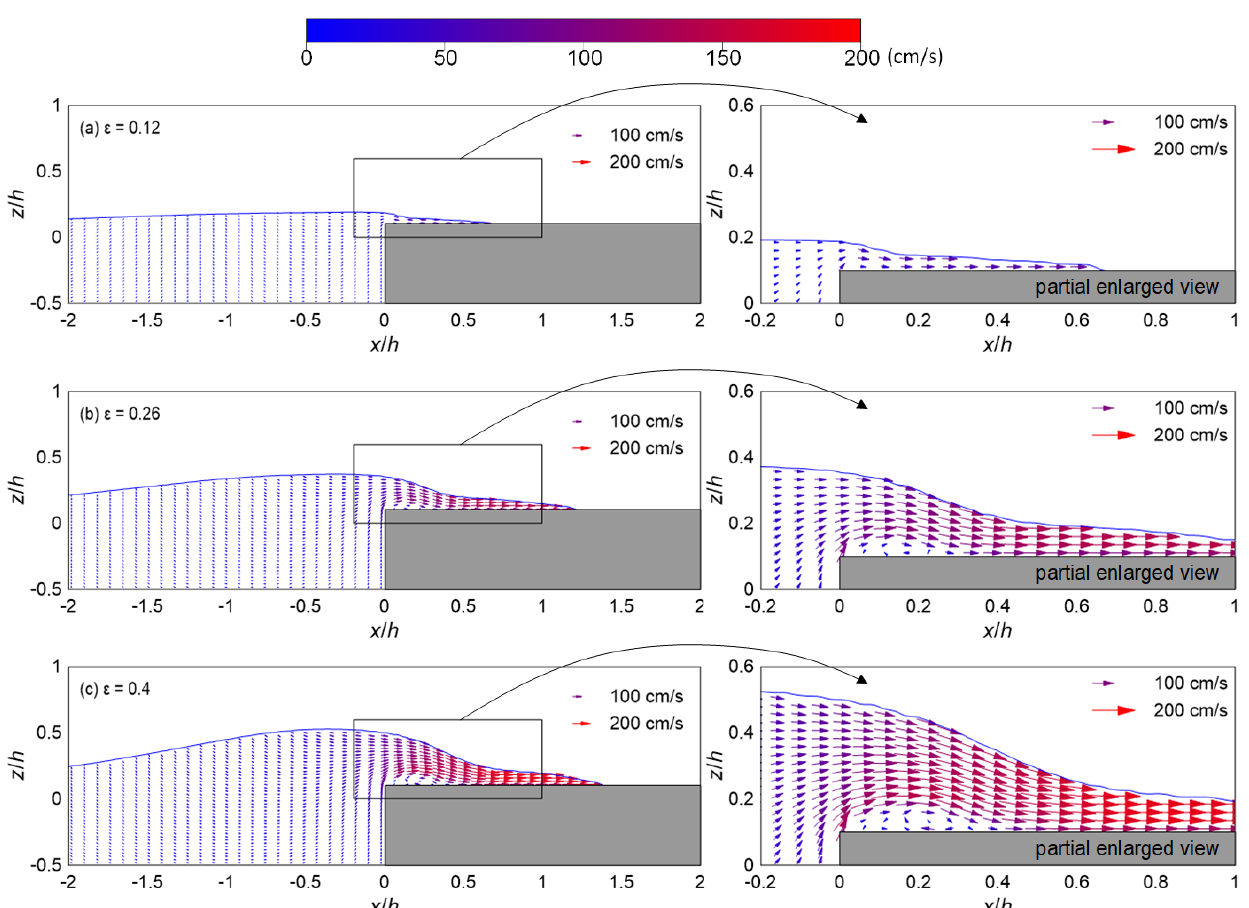
Figure 16. Wave and flow fields around the VR when the maximum water level occurs at the front of the vertical wall ( 𝑥/ℎ = 0 ).